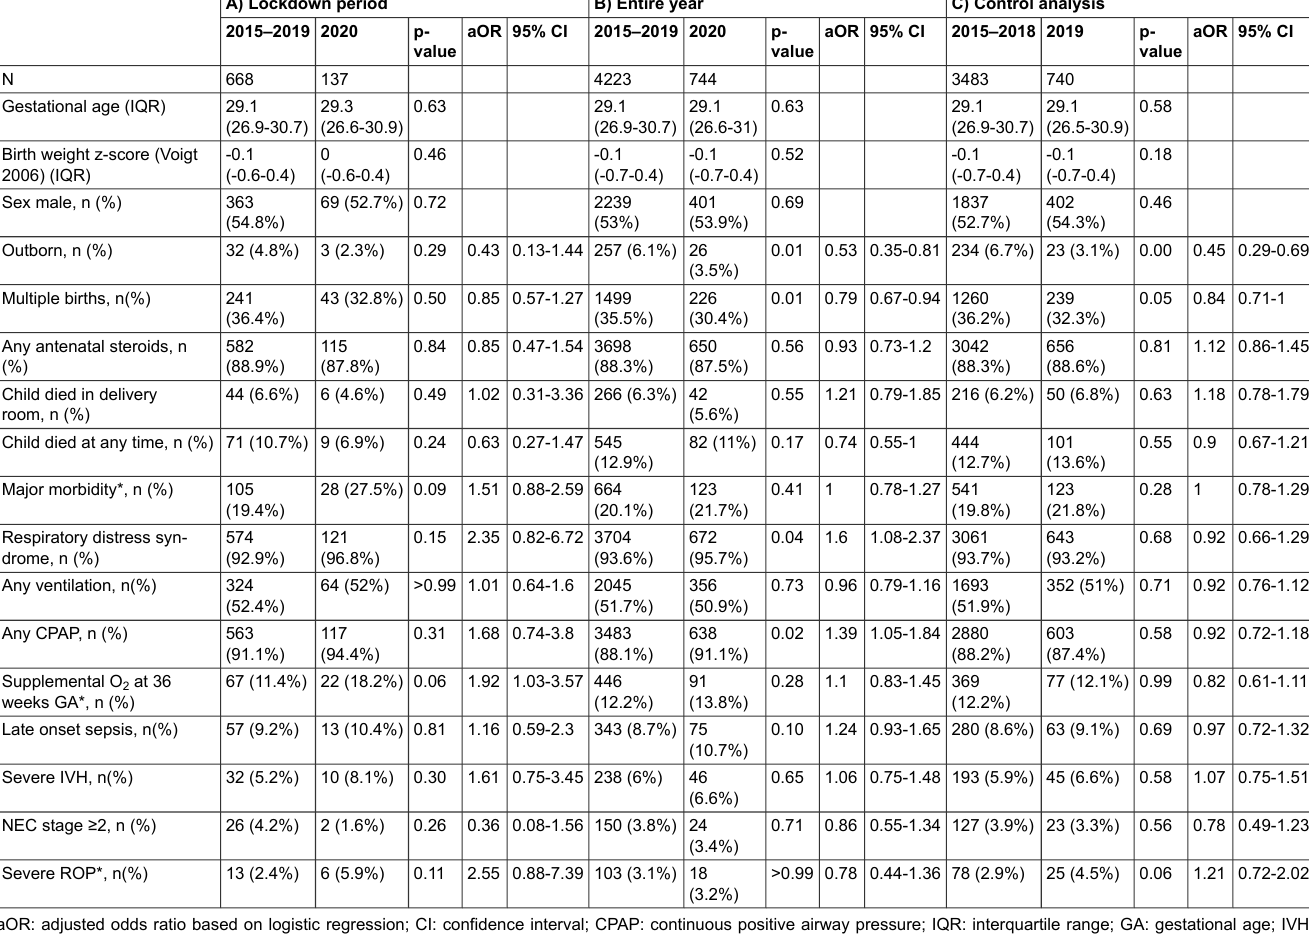
Table 2: Incidence, treatment and outcome of infants born between 22 and 31 weeks gestation based on SwissNeoNet